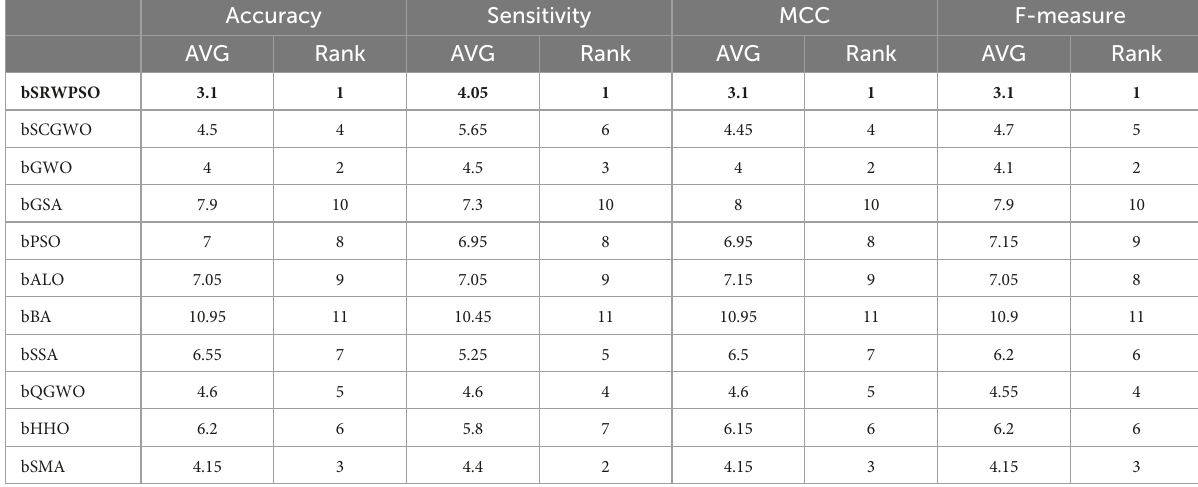
TABLE 22 The results of the Friedman